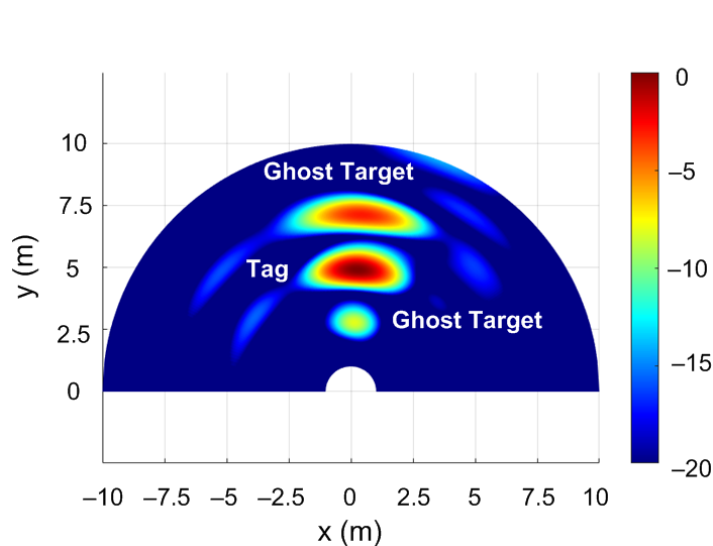
Figure 21. Measured range–Doppler map including two ghost targets generated with a Doppler frequency shift of 1000 Hz with the tag approaching the radar.